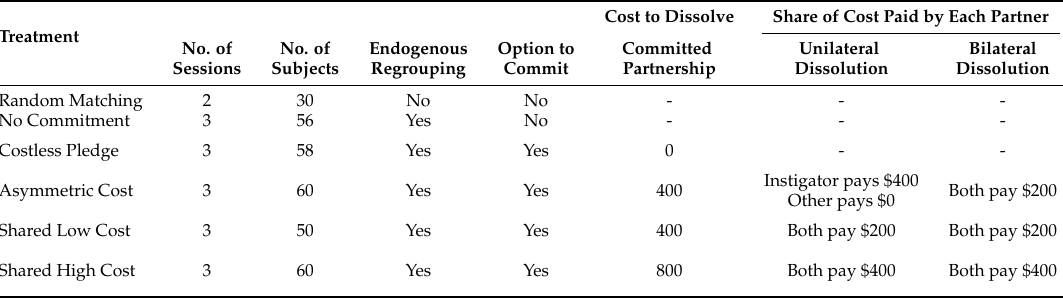
Table 1. Summary of treatments